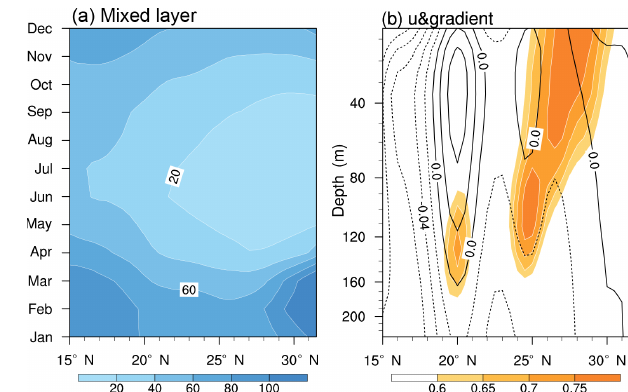
Figure 2. (a) Latitude–time section of the climatological monthly mean mixed-layer depth (units: meters) calculated by SST − T H = 0 . 5 ◦ C. (b) Latitude–depth section of the climatological zonal cur- rent velocity (black contour; units: ms − 1 ), superimposed with ocean temperature gradient (shading; units: ◦ C(100km) − 1 ); both are averaged over winter and spring. All three fields are averaged zonally over 140 ◦ E–170 ◦ W.